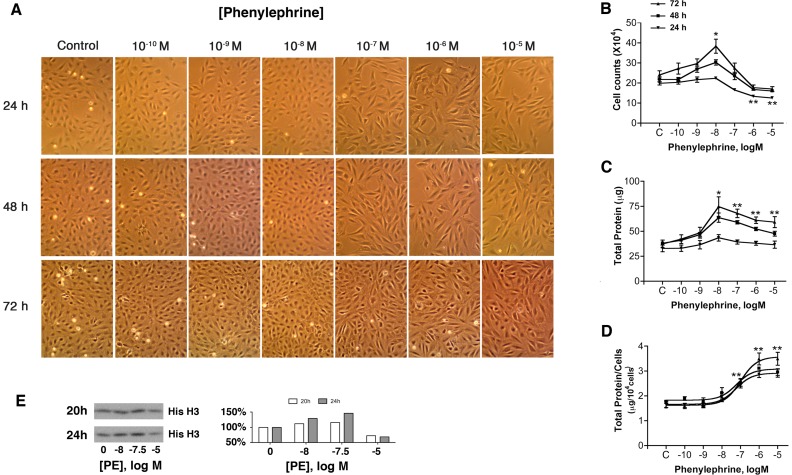
The α1aAR induces proliferation at low PE concentrations and antiproliferative hypertrophy at high PE concentrations.Rat-1 cells stably expressing the α1aAR at 1.77 pmol/mg of total protein were incubated at 37°C under 5% CO2 in serum-free DMEM for 24, 48 and 72 h with the indicated concentrations of PE (10−10 to 10−5 M). The effect of PE on α1aAR-induced proliferative and hypertrophic growth responses was determined by side-by-side (A) morphological observation, (B) cell counts; (*), P<0.05 at 48 and 72h; (**), P<0.05 at 24h, (C) protein quantitation per well; (*), P<0.05 at 48h; (**) P<0.05 at 48 and 72h, and (D) estimation of protein per cell; (*), P<0.05 at all times. All compared by 1-way ANOVA to basal (n = 3–8). E Representative Western blot images and semi-quantitative analysis of histone H3 protein levels at 20 and 24 hours.